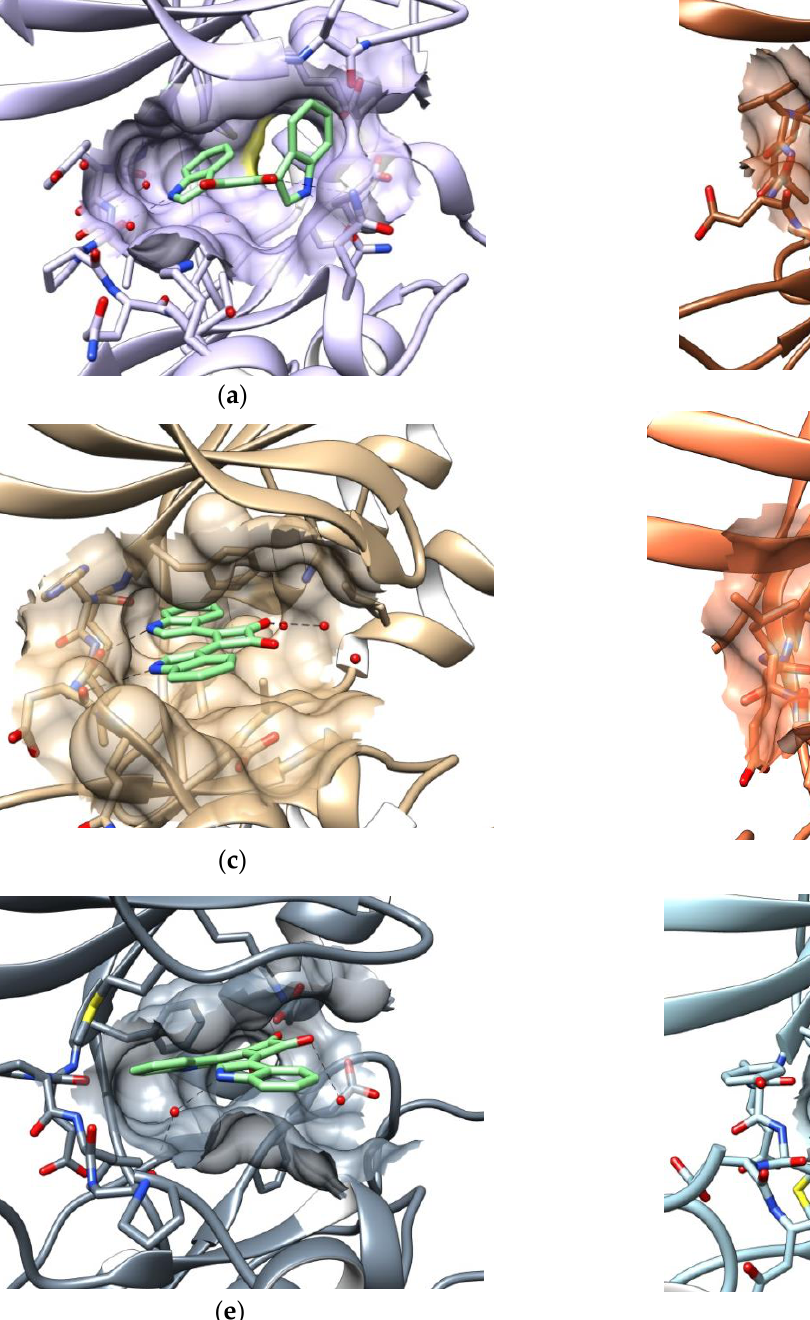
Figure 2. Poses of 2a in the ATP binding site of six plasmodial protein kinases resulting from molecular docking. ( a ) Pf GSK- 3 homology model based on template 1J1B. ( b ) Pf map-2 (PDB: 3NIE). ( c ) Pf PK5 (PDB: 1V0P). ( d ) Pf CDPK2 (PDB: 4MVF).